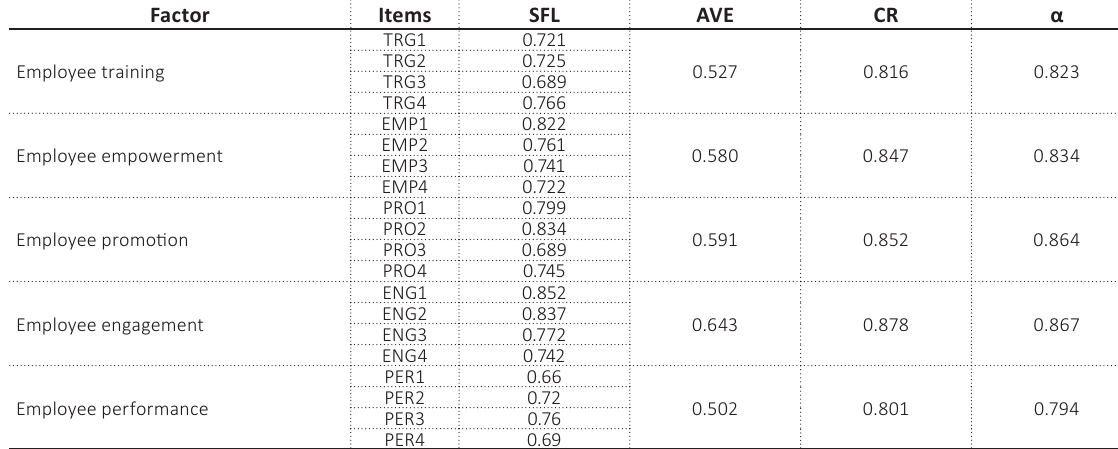
Table 3. Factor structure of questionnaire items Factor Items SFL AVE CR α